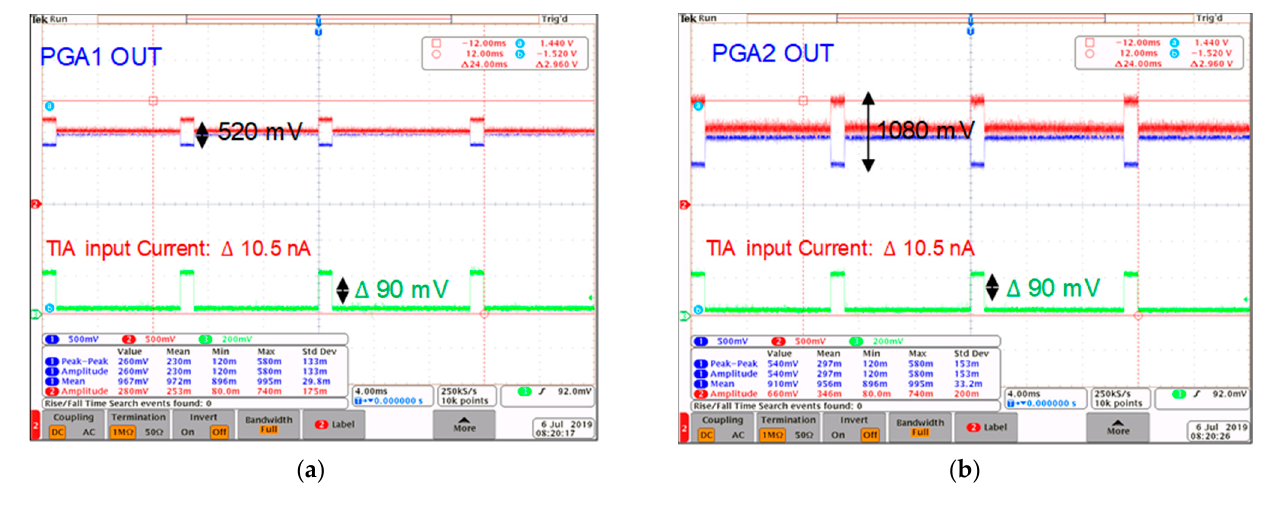
Figure 17. The measured output of the ( a ) PGA1 and ( b ) PGA2. Table 1. Comparison table over various TIA structures.